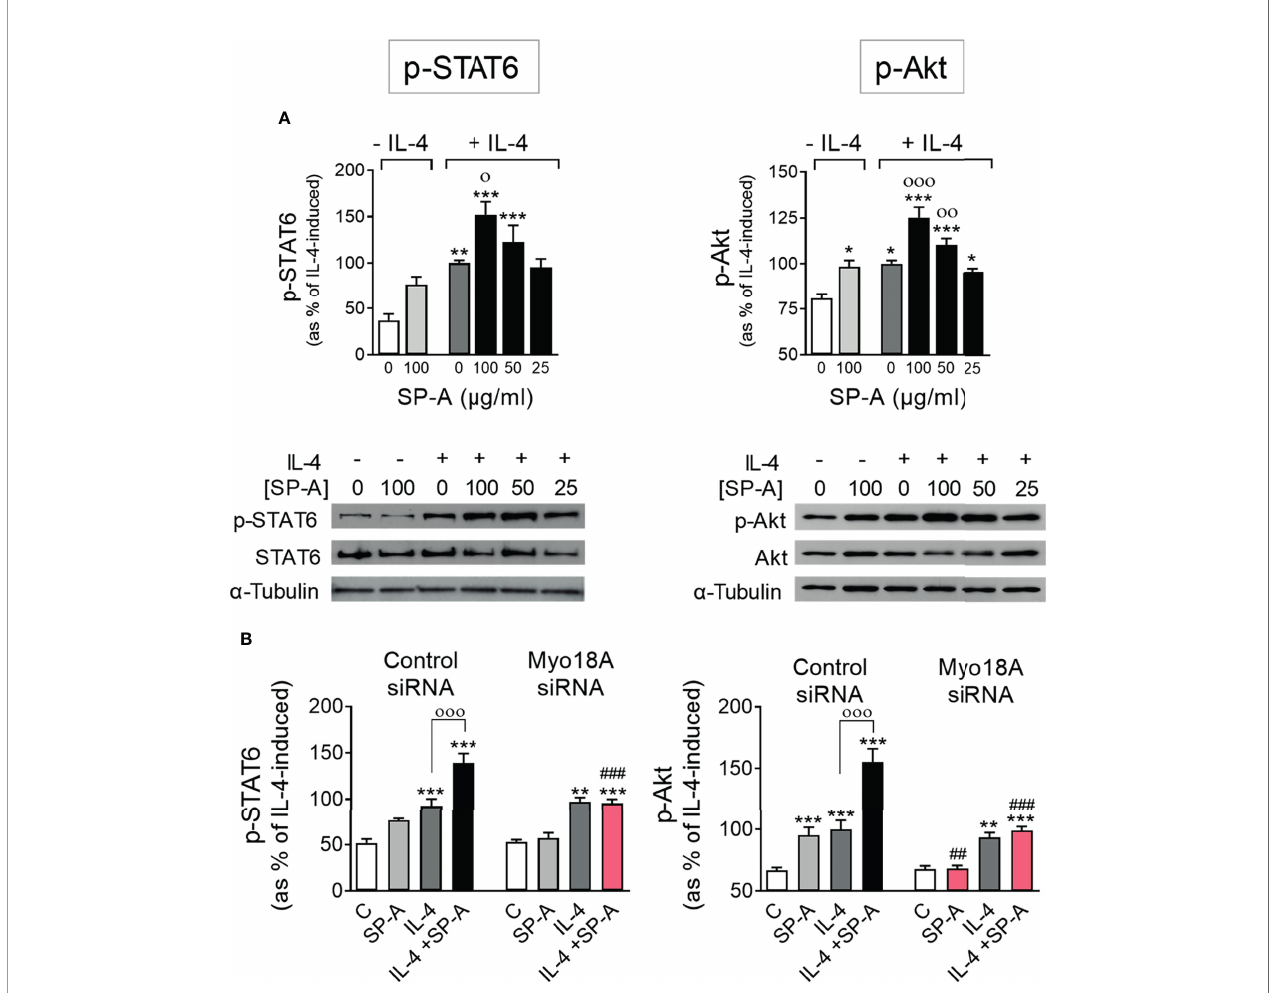
FIGURE 1 | SP-A acts through Myo18A to enhance STAT6 and Akt activation elicited by IL-4 in AMs. (A) Puri fi ed rat AMs were treated with or without IL-4 (1 m g/ml) in the presence or absence of SP-A at the indicated concentrations. STAT6 and Akt phosphorylation relative to total STAT6 or Akt, respectively, were analyzed by Western blot. A representative Western blot for p-STAT6 (Tyr641) or p-Akt (Ser473) is shown below each graph. (B) AMs were nucleofected with Myo18A (RSS322720) or control siRNA. Cells were then stimulated with or without IL-4 (1 m g/ml) and/or SP-A (100 m g/ml), and p-STAT6 and p-Akt were analyzed by Western blot. The data shown are means ± SEM of three different AM cultures with at least three biological replicates. ANOVA followed by the Bonferroni multiple-comparison test was used. * p < 0.05, ** p < 0.01, and *** < 0.001 when compared with untreated cells. о p < 0.05, оо p < 0.01, and ооо p < 0.001 when SP-A+IL-4-treated macrophages were compared with IL-4- treated macrophages. ## p < 0.01 and ### p < 0.001 when the effect of Myo18A siRNA is compared with siRNA